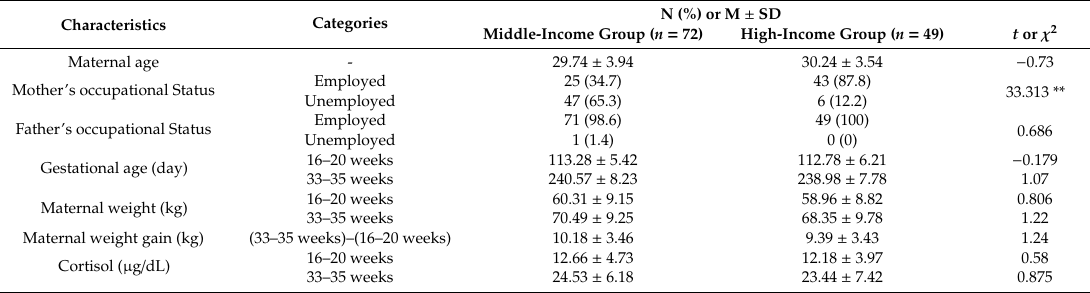
Table 1. Descriptive statistics of participants’ characteristics ( n = 121).